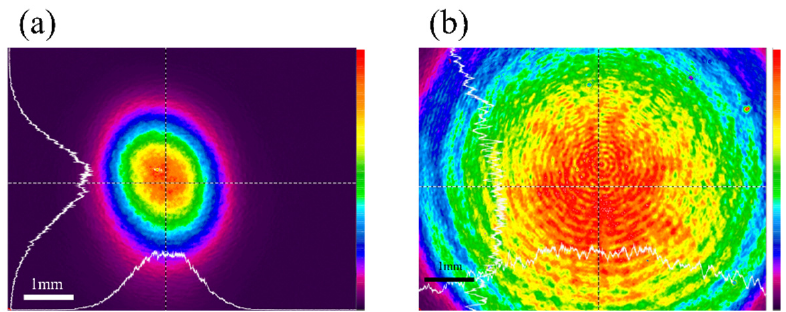
Figure 7. ( a )The profile of the femtosecond laser beam before passing an aperture diaphragm; ( b ) the profile of the femtosecond laser beam after passing an aperture diaphragm.